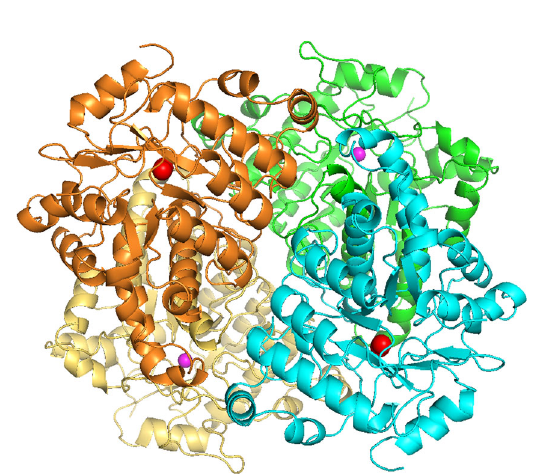
Fig. 4 Overall structure of AibH1H2 complex. Ribbon diagram of an α 2 α ′ 2 heterotetrameric unit of two AibH1 subunits (yellow and green) and two AibH2 subunits (orange and cyan) are shown. Pink and red spheres are Zn and Fe ions,